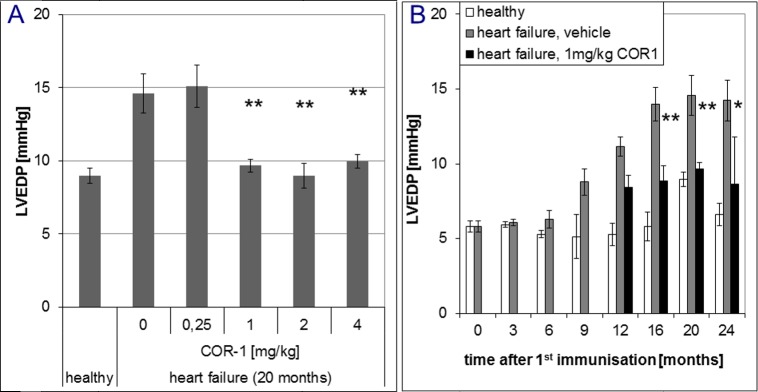
Effect of COR-1 on the left ventricular end-diastolic pressure (LVEDP) of rats with HF induced by immunisation with GST-ß1EC2 fusion proteins.A: Effects of COR-1 on the LVEDP after ten monthly treatments (20 months after the first immunization), as assessed by cardiac catheterization. Mean LVEDP (triplicate determinations in each animal) are shown with SEM for ß1EC2HF rats treated with vehicle (n = 5), 0.25 mg/kg BW COR-1 (n = 4), 1 mg/kg BW COR-1 (n = 10), 2 mg/kg BW COR-1 (n = 5), and 4 mg/kg BW COR-1 (n = 9), and of healthy control rats. ** indicates strong statistical significance (p<0.005) compared to the HF vehicle group. The resulting ANOVA analyses showed overall significance, and post-hoc specific inter-group p values were 0.000 for HF + vehicle vs. healthy, 0.000 for HF + 0.25 mg/kg COR-1 vs. healthy, and 0.001 for HF + 1 mg/kg COR-1 vs. HF + vehicle, 0.001 for HF + 2 mg/kg COR-1 vs. HF + vehicle, 0.002 for HF + 4 mg/kg COR-1 vs. HF + vehicle. Also, 0.001 for HF + 1 mg/kg COR-1 vs. HF + 0.25 mg/kg COR-1, 0.01 for HF + 2 mg/kg COR-1 vs. HF + 0.25 mg/kg COR-1, 0.02 for HF + 4 mg/kg COR-1 vs. HF + 0.25 mg/kg COR-1. All other post-hoc analyses yielded non significant results. B: Time course of LVEDP of healthy rats (white diamonds, n = 3 to 6) and of ß1EC2HF rats receiving vehicle (grey squares, n = 3 to 5), at intervals of three and four months. From the 12th month after the first immunization on, 1 mg/kg COR-1 treated HF rats were included into the analysis (black triangles, n = 4 to 10). Mean LVEDPs with SEM are shown (n = number of respective rats).*(p<0.05) and **(p<0.005) indicate statistical significance compared to the HF vehicle group. Analysis of variance (ANOVA) showed no differences at baseline, but significant worsening of LVEDP in immunized HF rats compared to healthy control rats, starting 12 months after the first immunisation. HF rats treated with 1 mg/kg COR-1 differed significantly from the HF vehicle group, but did not significantly differ from healthy control rats at 16, 20, and 24 months.